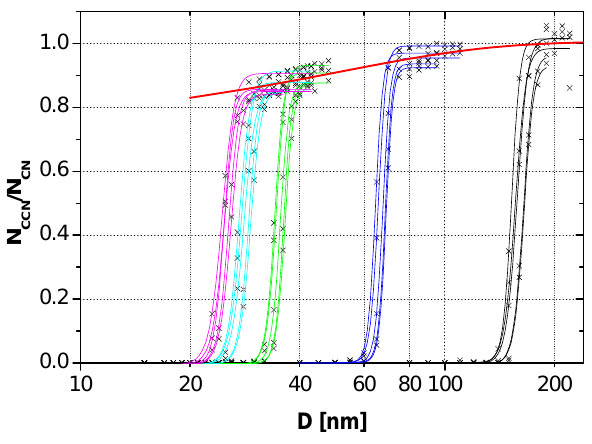
Fig. 1. CCN efficiency spectra obtained from 5 calibration exper- iments with ammonium sulfate aerosol performed during the cam- paign (data points and CDF fits). Different colors indicate the differ- ent supersaturation levels. The red line is the asymptotic function that was used to correct for different counting efficiencies of the CPC and the CCNC ( f corr